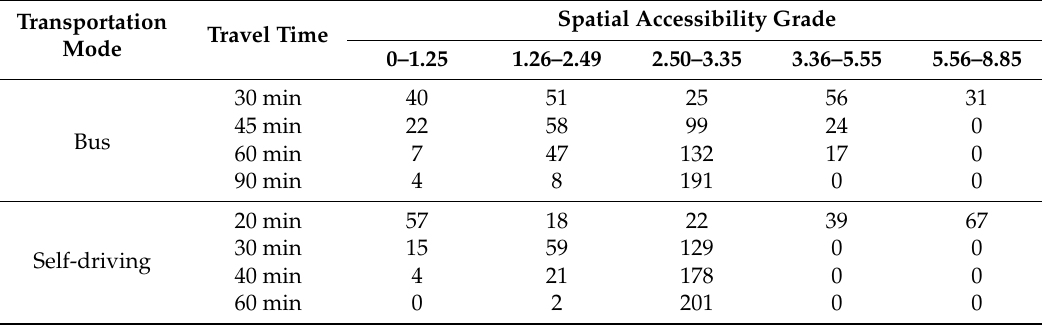
Table 1. Spatial Accessibility Grade and the numbers of evaluation units for each